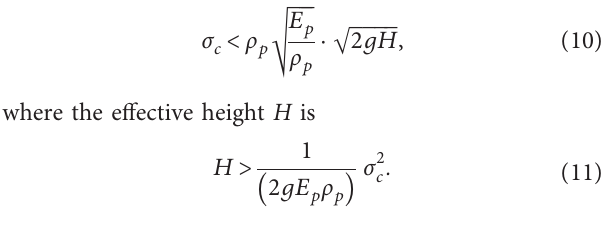
Table 3: Mechanical properties of rock used in impact